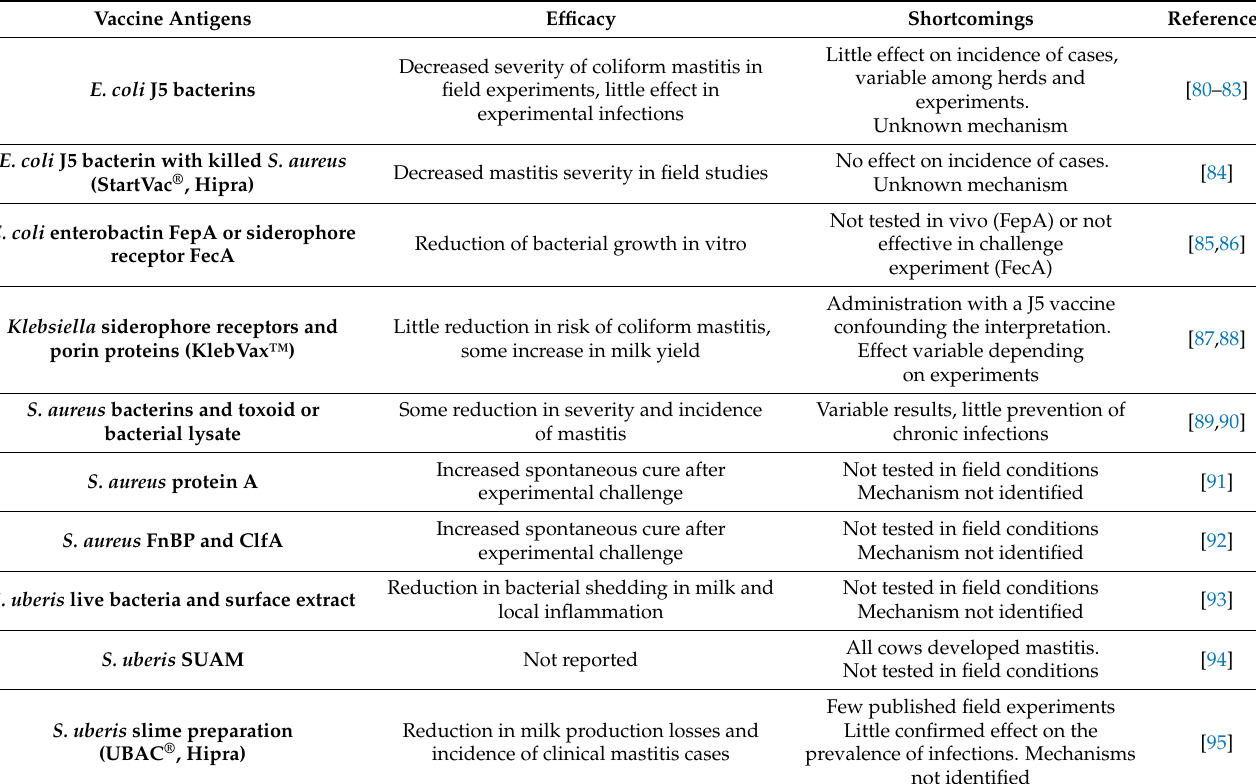
Table 2. Illustrative vaccine trials in cows against common mastitis